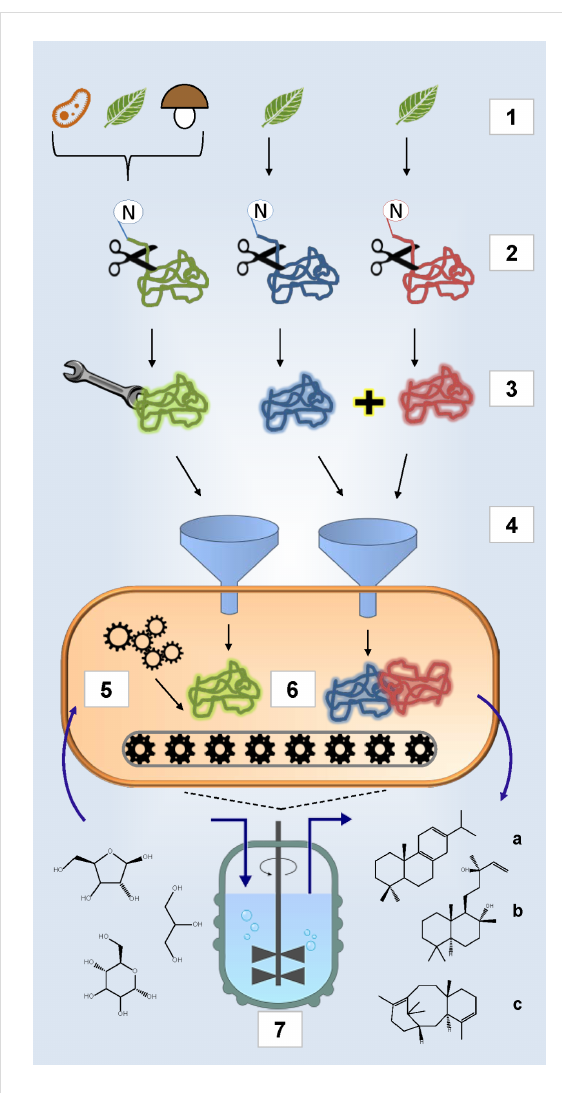
Figure 1: Implementation of a microbial cell factory. 1: Selection of en- zymes from different species. P450 and related reductase enzymes (indicated with blue and red knots respectively) derive almost exclu- sively from plants; terpene synthases and other enzymes that are involved in precursor formation (indicated with green knot) can be ob- tained from various organisms (indicated through symbolic bacteria, leaf (representing plants in general) and fungi). 2: Eukaryotic enzymes have to be engineered for functional and soluble expression in prokaryotic hosts like E. coli , Removal of the N-terminal and thereby the cell-wall-localization domain (indicated through scissors) is a stan- dard procedure in engineering plant enzymes; 3: Further engineering steps are not mandatory but often entail site-directed mutagenesis (in- dicated through wrench) of TPS (green) for product modulation or introduction of a linker-coding sequence for co-expression of P450 monooxygenase and reductase (blue and red); 4: Heterologous expression in E. coli (depicted in orange). Construction of synthetic operons and screening for highest yield of plasmid systems generally precedes genomic integration; 5: Isoprenoid precursor supply: precur- sor flux has to be balanced carefully to avoid metabolic overload and accumulation of unwanted byproducts; 6: Downstream terpenoid bio- synthesis using heterologous enzymes; 7: Upscaling of terpene pro- duction in fermentation systems using different carbon sources (left) for optimally engineered E. coli strains is a potential future source for valuable diterpenes like miltiradiene (a), sclareol (b) or taxadiene